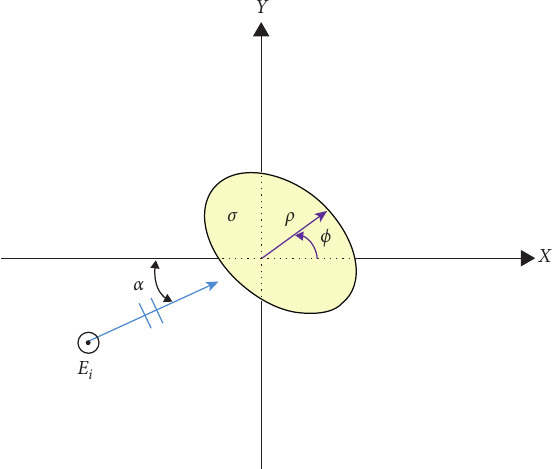
Figure 3: Geometry of a cylinder in free space illuminated by an incident plane wave E